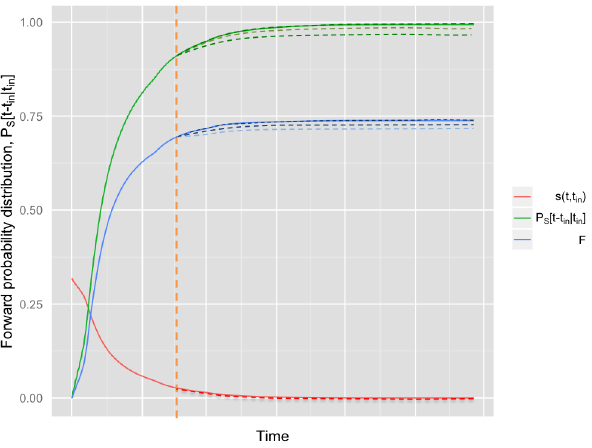
Figure 6. Representation of the forward probability of the outputs: in red the relative storage, s(t , t in ) , in green the output probability, P s [ t − t in | t in ] , and in blue the relative discharge function F , defined in the text. The difference between P s [ t − t in | t in ] and F is the func- tion G , defined in the text. The orange dashed line represents the generic instant t , after which P s [ t − t in | t in ] and F are